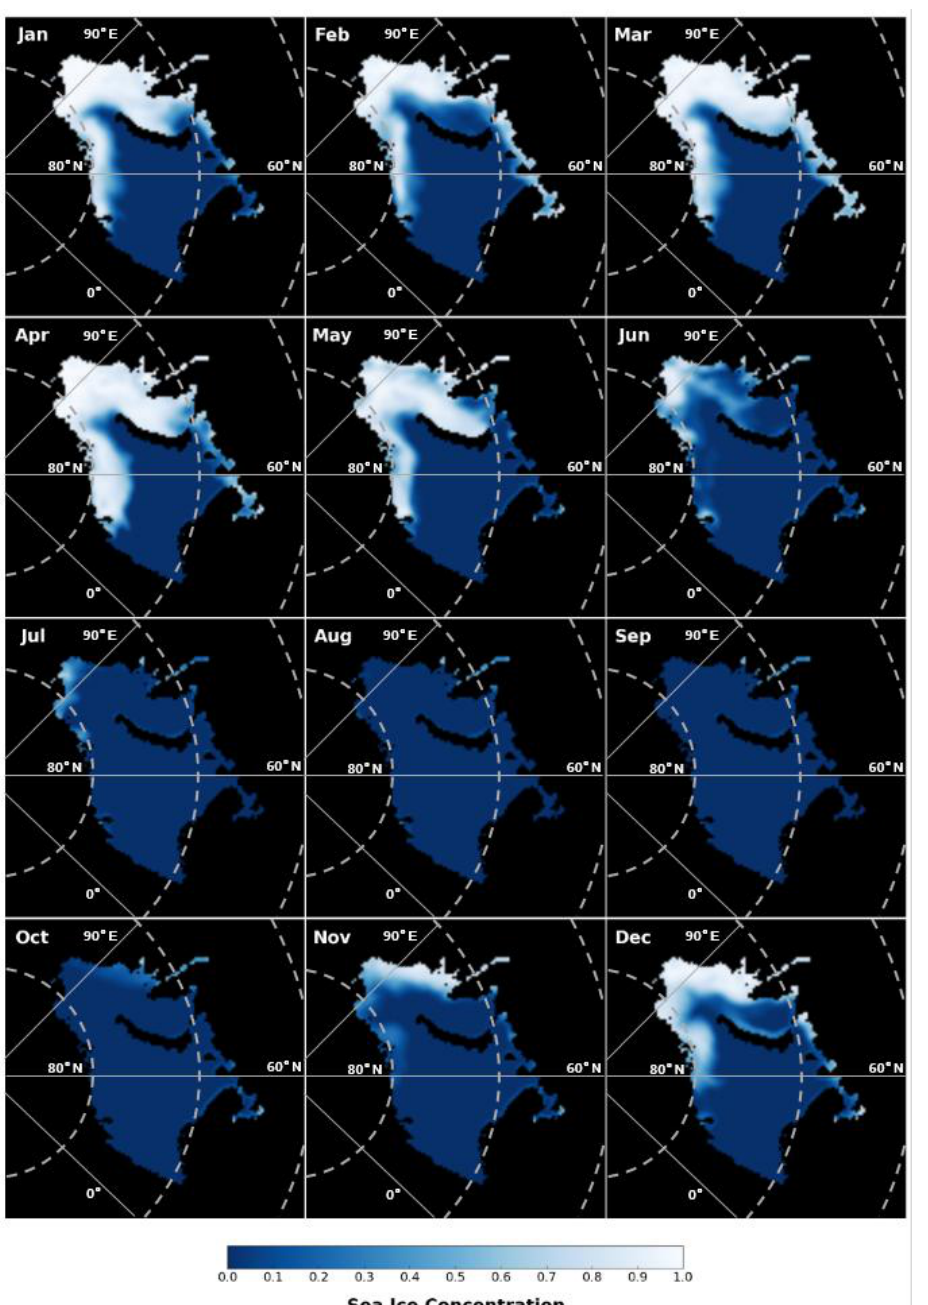
Figure 6. Satellite-observed monthly sea ice concentration in the Barents and Kara Seas in